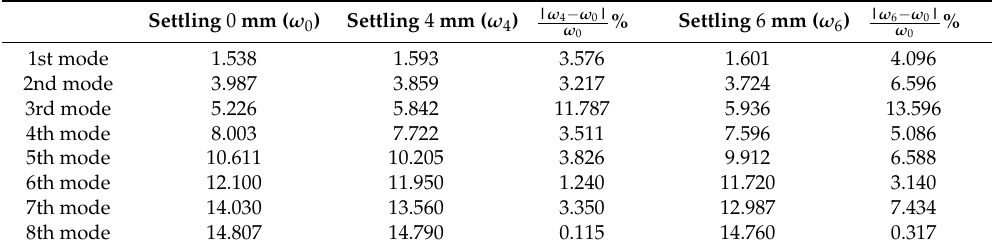
Table 3. Average modal frequency and change rate in the X direction of tower foot A before and after